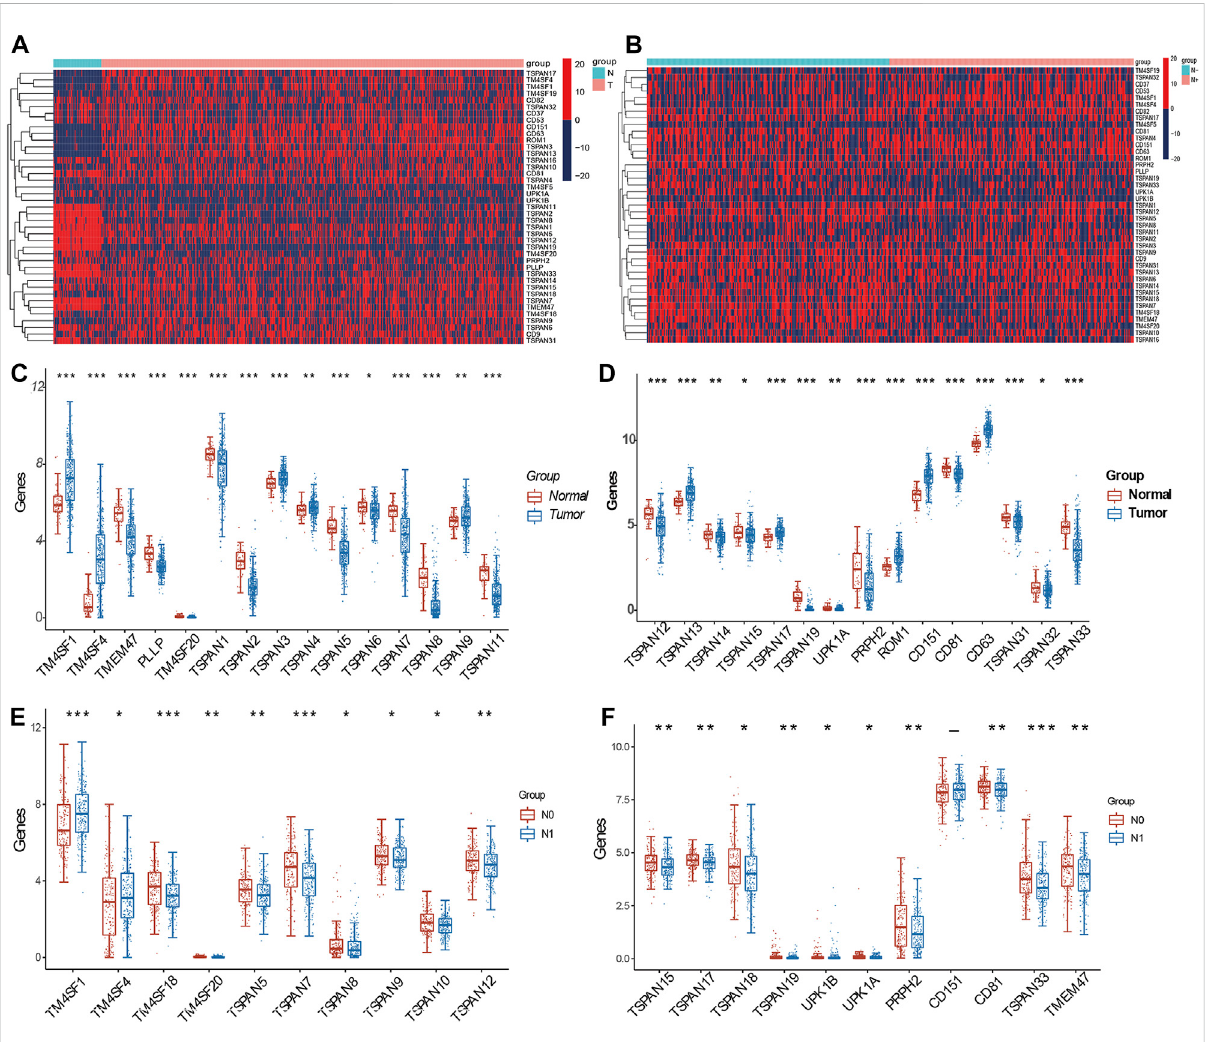
FIGURE 1 ExpressionofTM4SFsinthyroidpapillarycarcinoma. (A) DifferentiallyexpressedmRNAtranscriptheatmapbetweentumorandnormalgroupof 41 TM4SF family members in PTC patients. Red represents high expression and blue represents low expression; (B) Differentially expressed mRNA transcript heatmap between N0 and N1 group; (C,D) TM4SF members with signi fi cantly different expression between tumor and normal group;